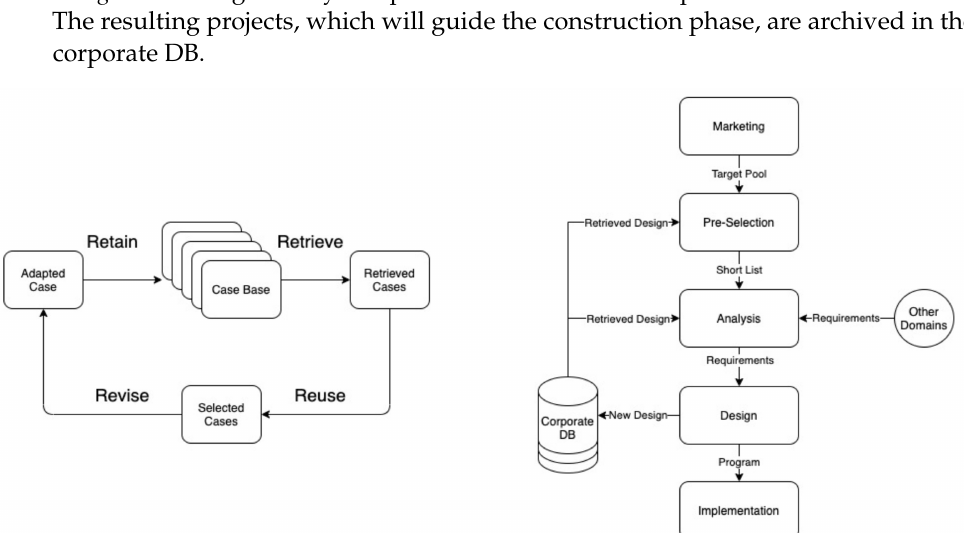
Figure 1. The Case Based Reasoning Cycle ( left ), the corporate workflow ( right